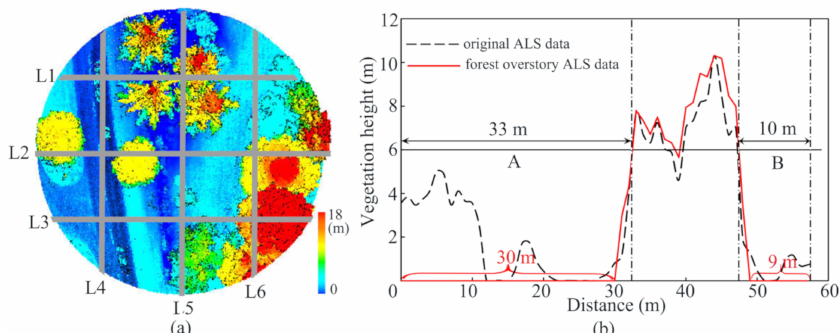
Figure 5. Graphs illustrating the sampling design of six different line transects at forest plot level ( a ) and comparison between the detected gap sizes obtained from original and stratified overstory ALS data ( b ).